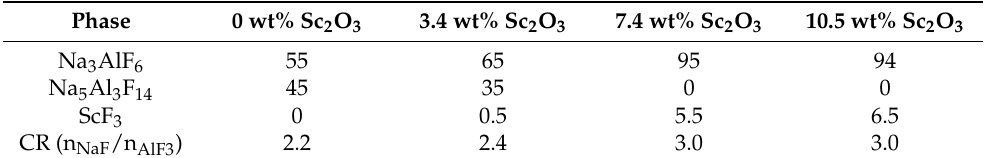
Table 1. Quantification of the phases of bath samples taken at each of the Sc 2 O 3 additions shown in Figure 1. The analysis was done using the TOPAS Software after XRD diffractograms of the samples. Values in wt%.